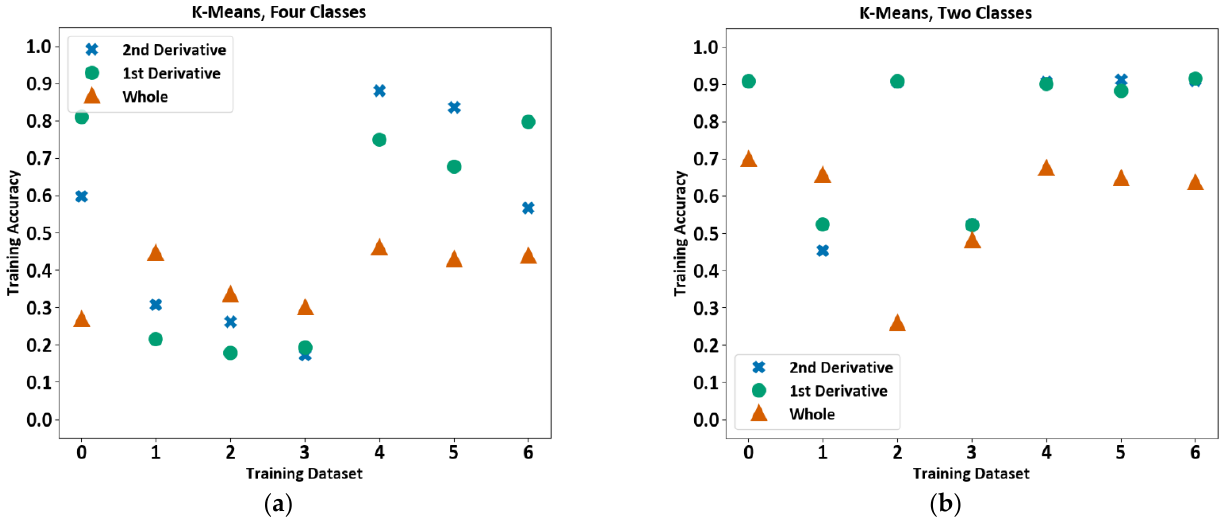
Figure 8. K-means training accuracy for each file using both the cooling period and derivatives of the cooling period. ( a ) The plot is showing results for four classes (copper, enamel, background, and tape), and ( b ) the plot is showing results for two classes (copper and enamel).